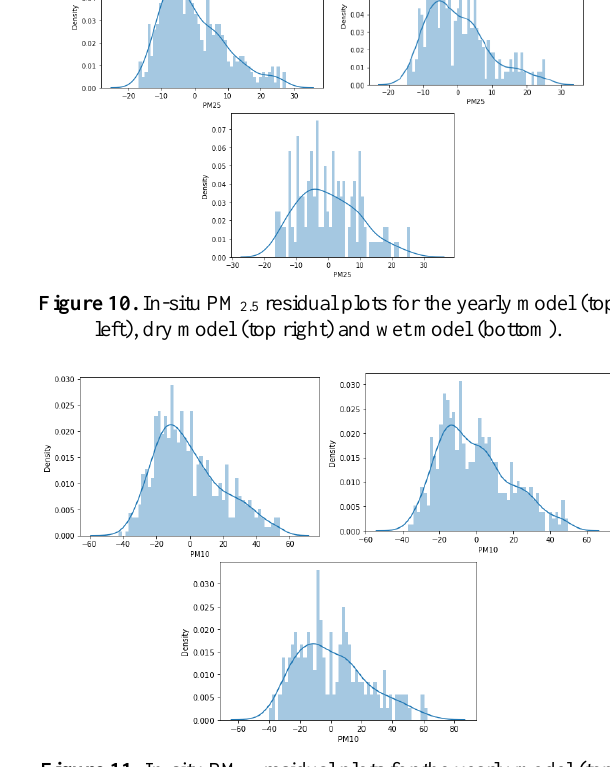
Figure 11. In-situ PM 10 residual plots for the yearly model (top left), dry model (top right) and wet model (bottom).